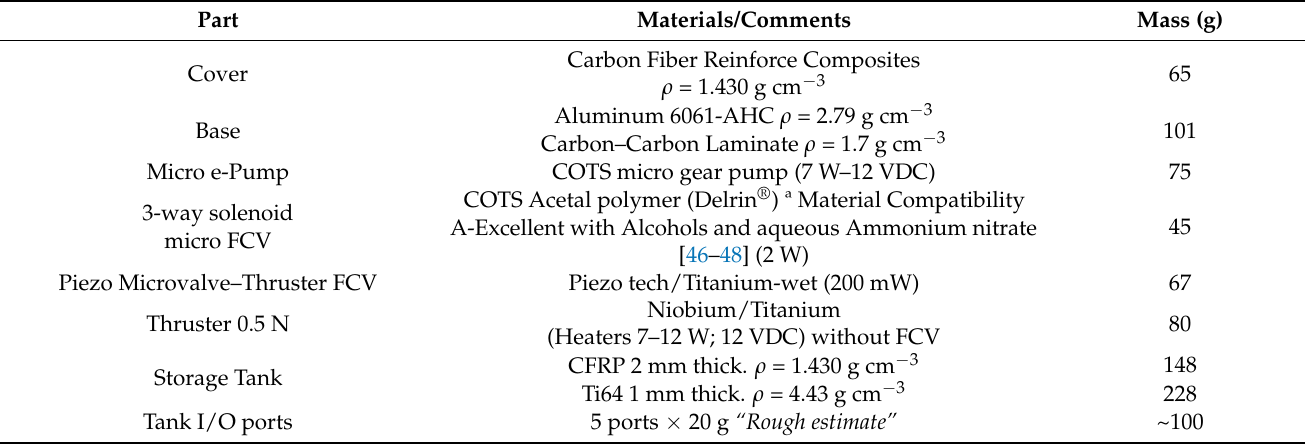
Table 10. Inert mass budget of MIMPS-G500mN propulsion